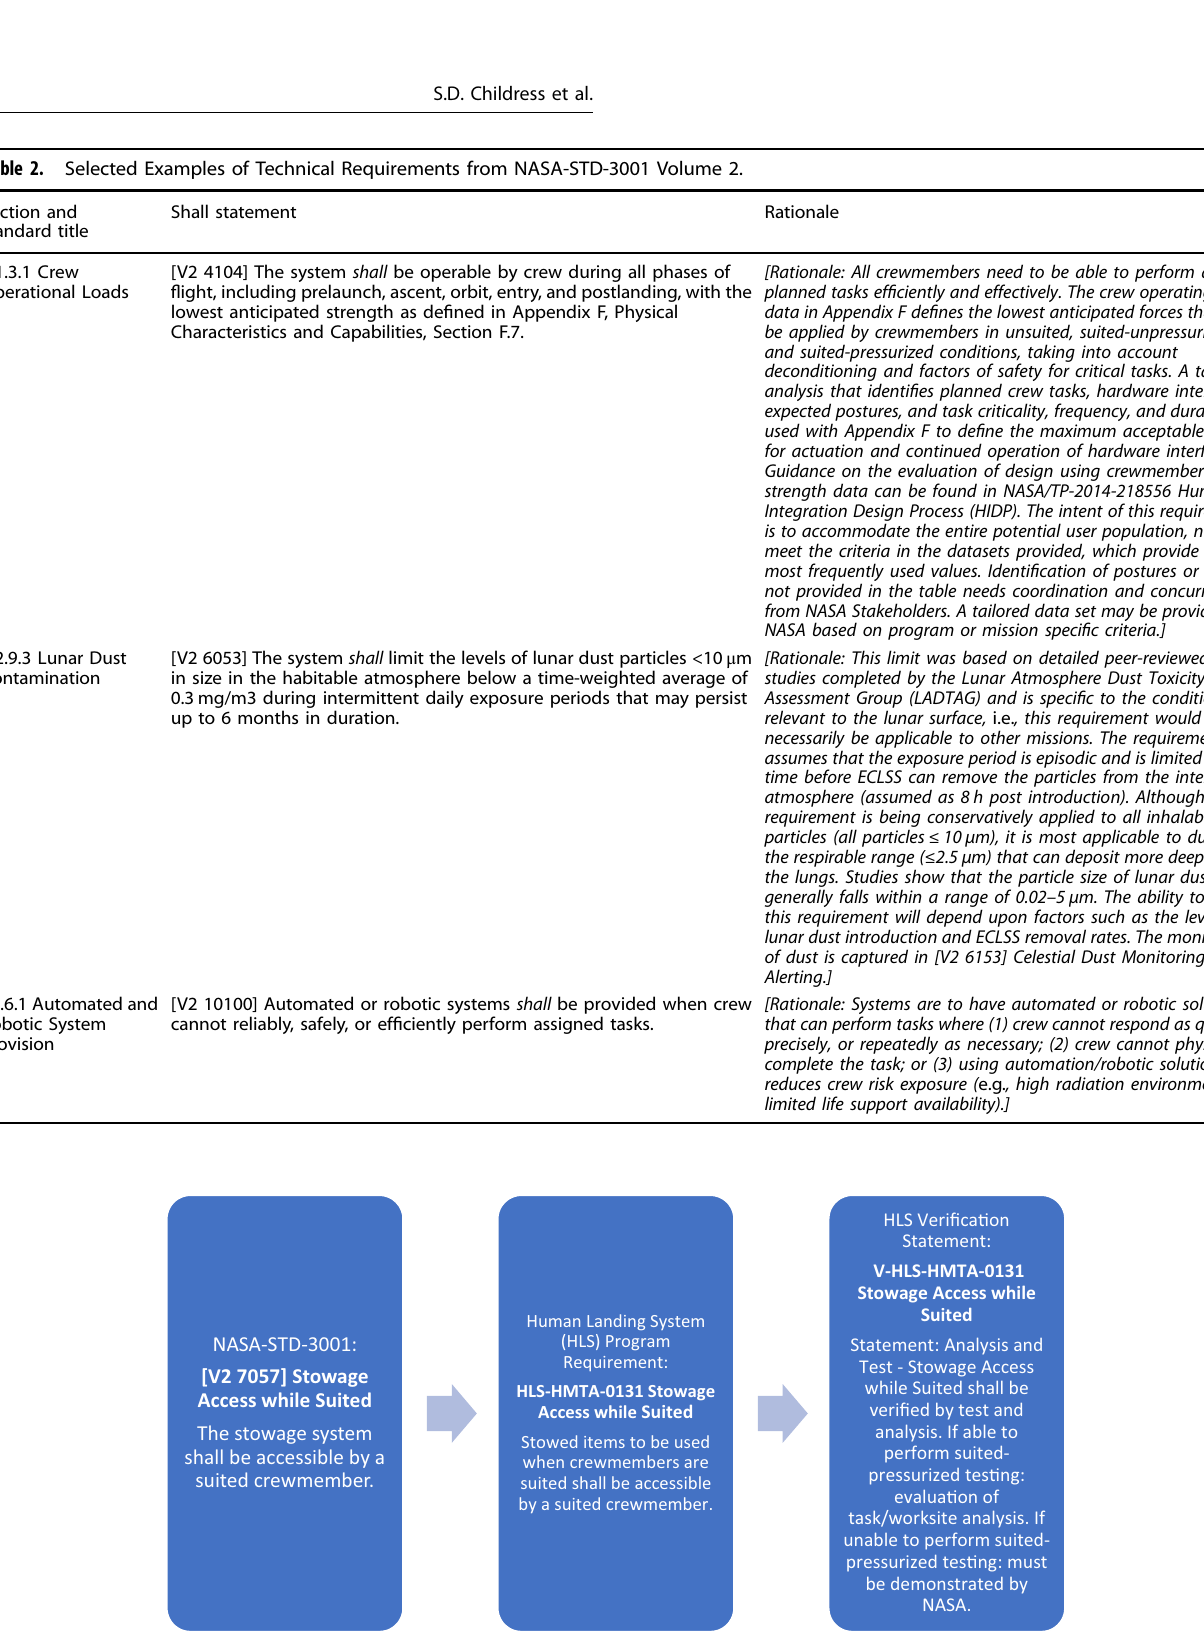
Fig. 2 Example of NASA-STD-3001 to program requirement fl ow. An example of how programs tailor individual technical requirements from NASA-STD-3001 to create and verify program-speci fi c